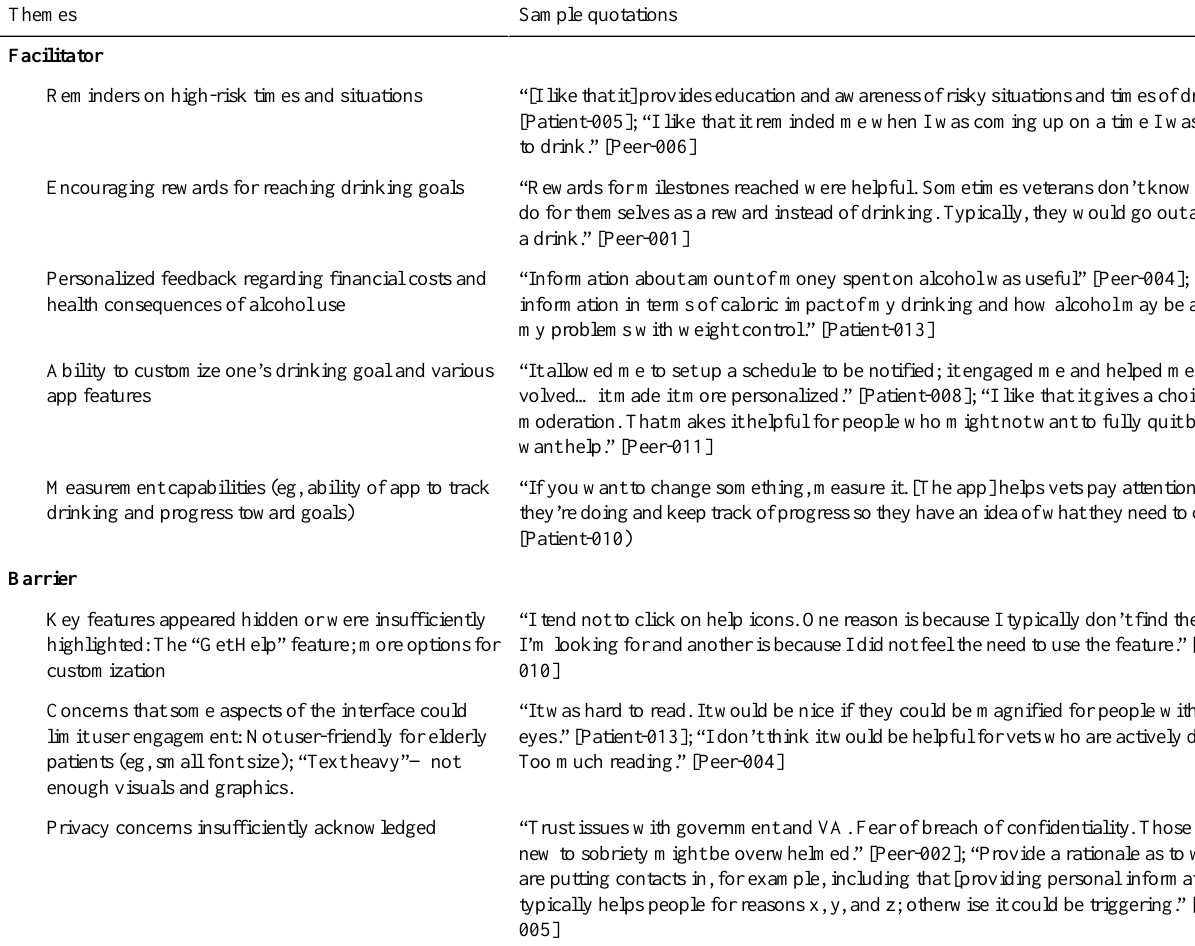
Table 3. Facilitators and barriers to engagement with Step Away.